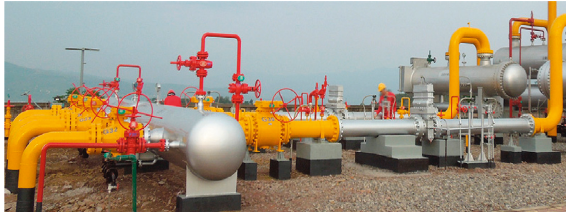
Figure 11: The inlet pipelines after modifications.